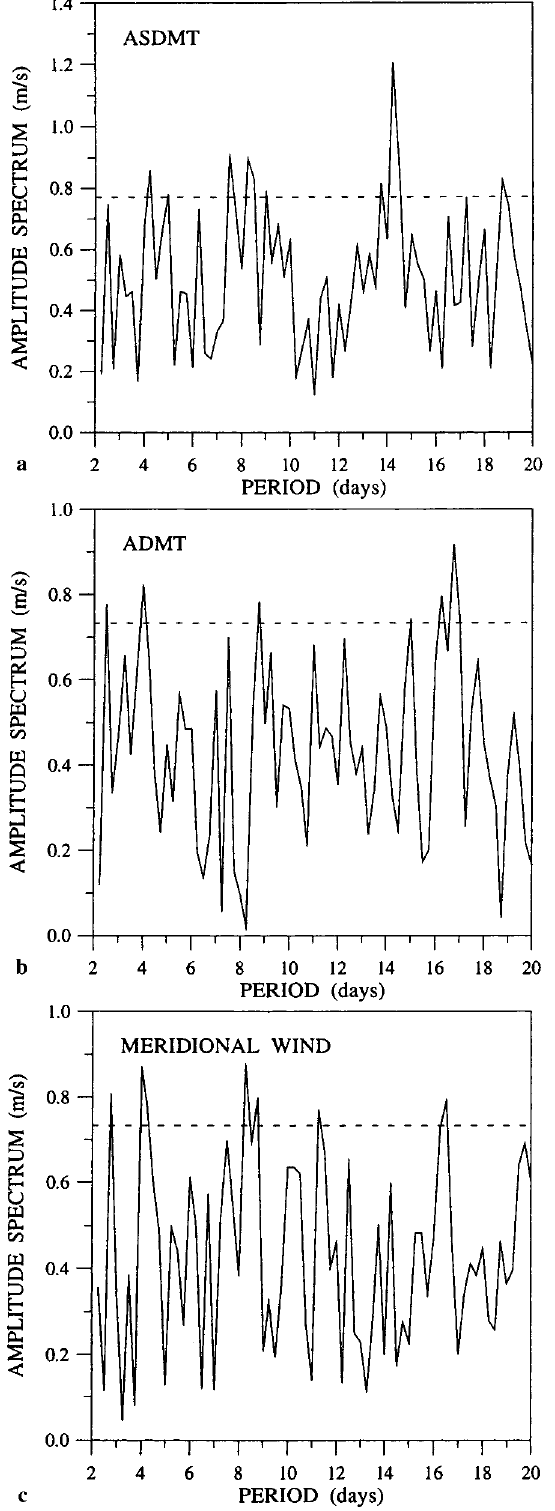
Fig. 2a–c. The same as Fig. 1, but for: a the amplitudes of the semidiurnal tide in the meridional wind ( ASDMT ); b the amplitudes of the diurnal tide in the meridional wind ( ADMT ); c the prevailing meridional